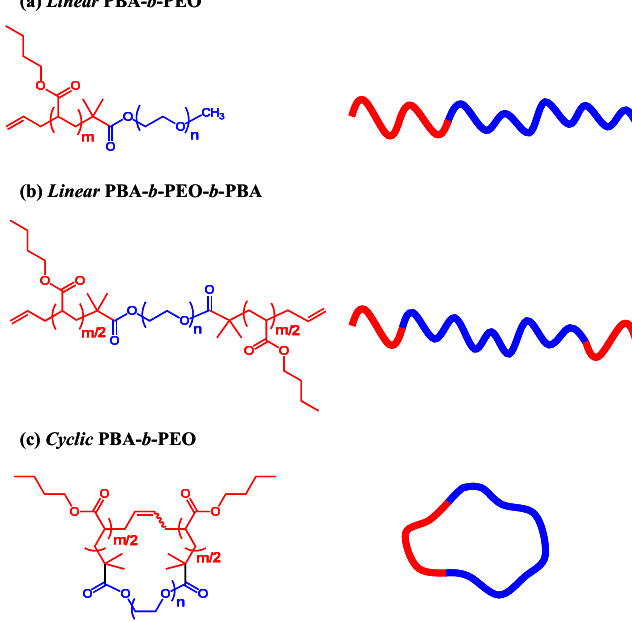
Figure 1. Chemical structures of the amphiphilic block copolymers used in this study.